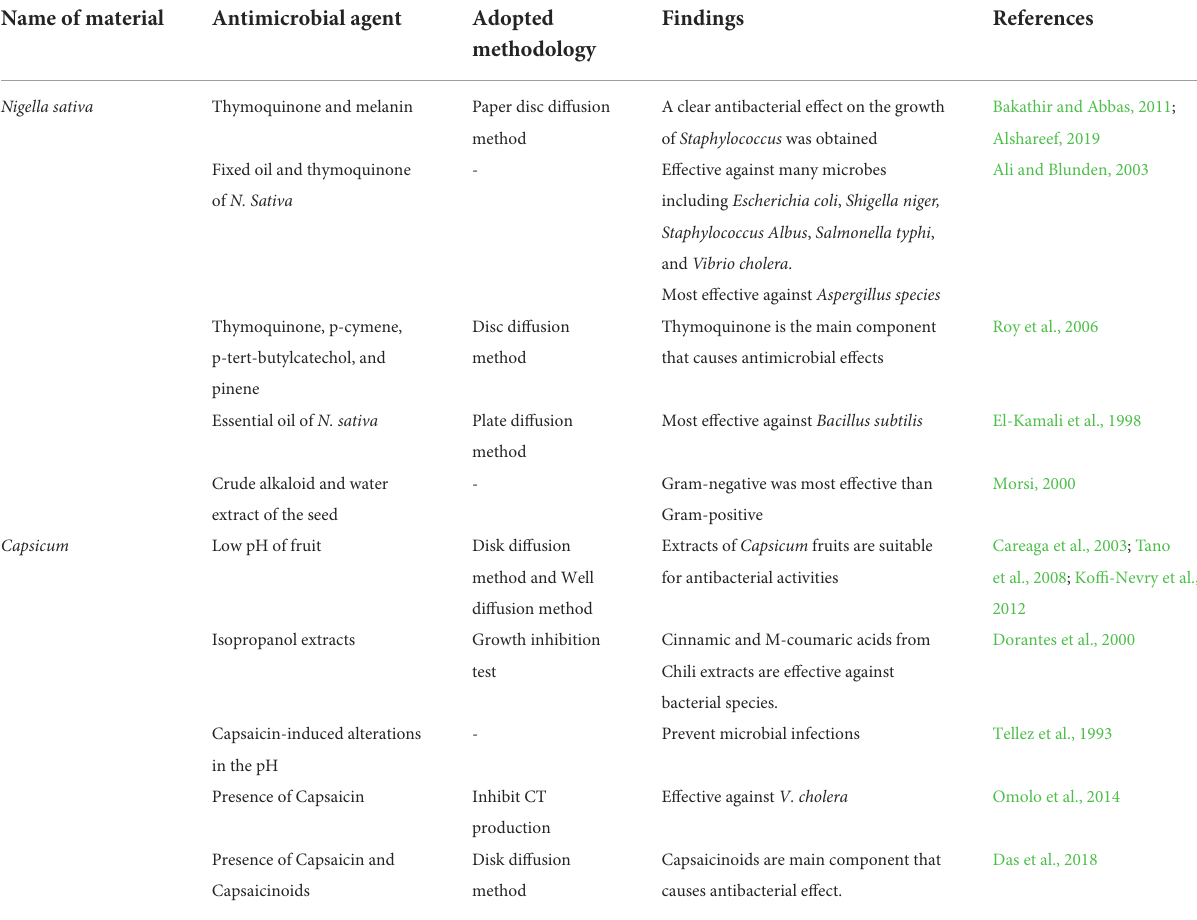
TABLE 1 Nigella sativa and Capsicum as an antimicrobial